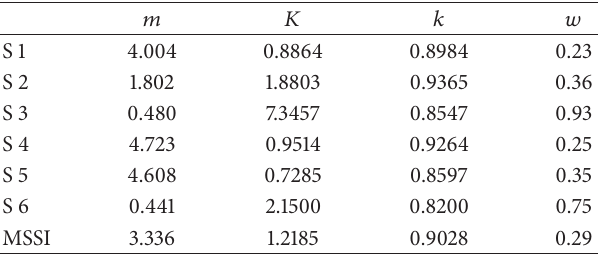
Figure 6: Sorption isotherms where mass of adsorbed water is expressed per unit specific surface area (m 2 of rock). Points: experimental data; lines: fitted GDW isotherms. Table 3: Coefficients of GDW sorption isotherms (see (4)) of studied